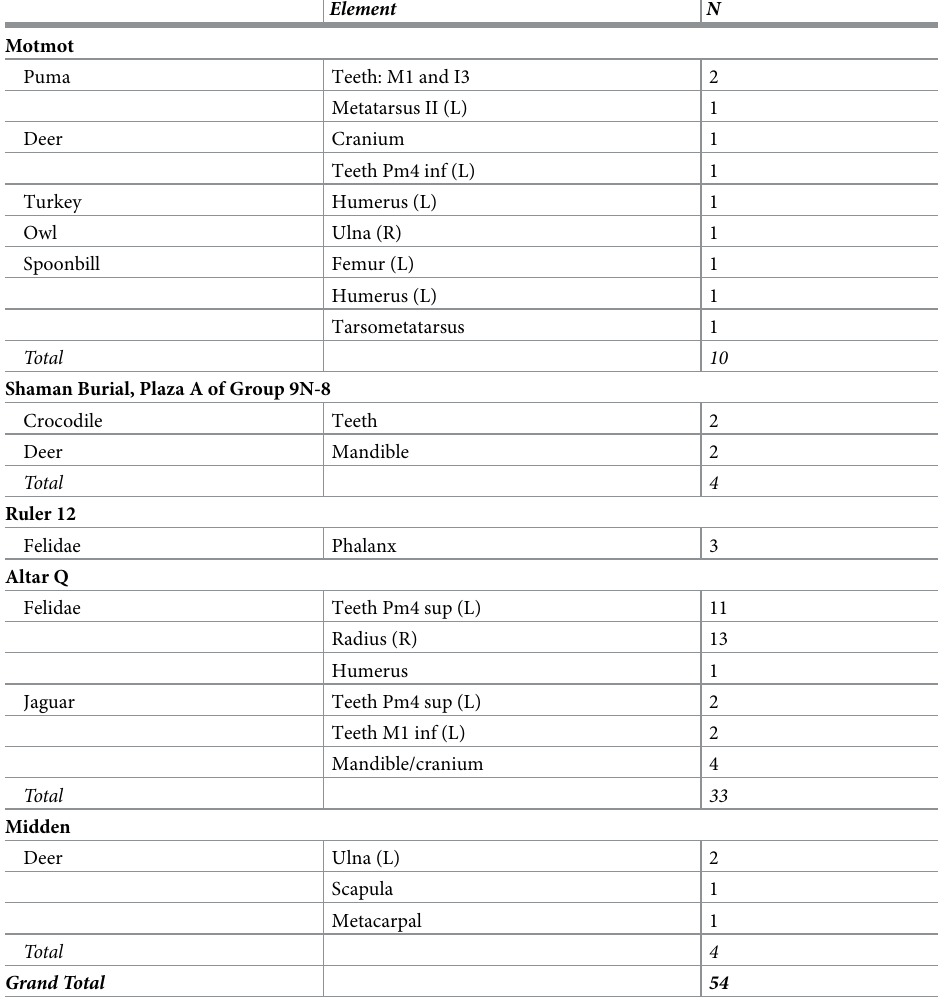
Table 2. Number of elements sampled from each context for isotope analysis.